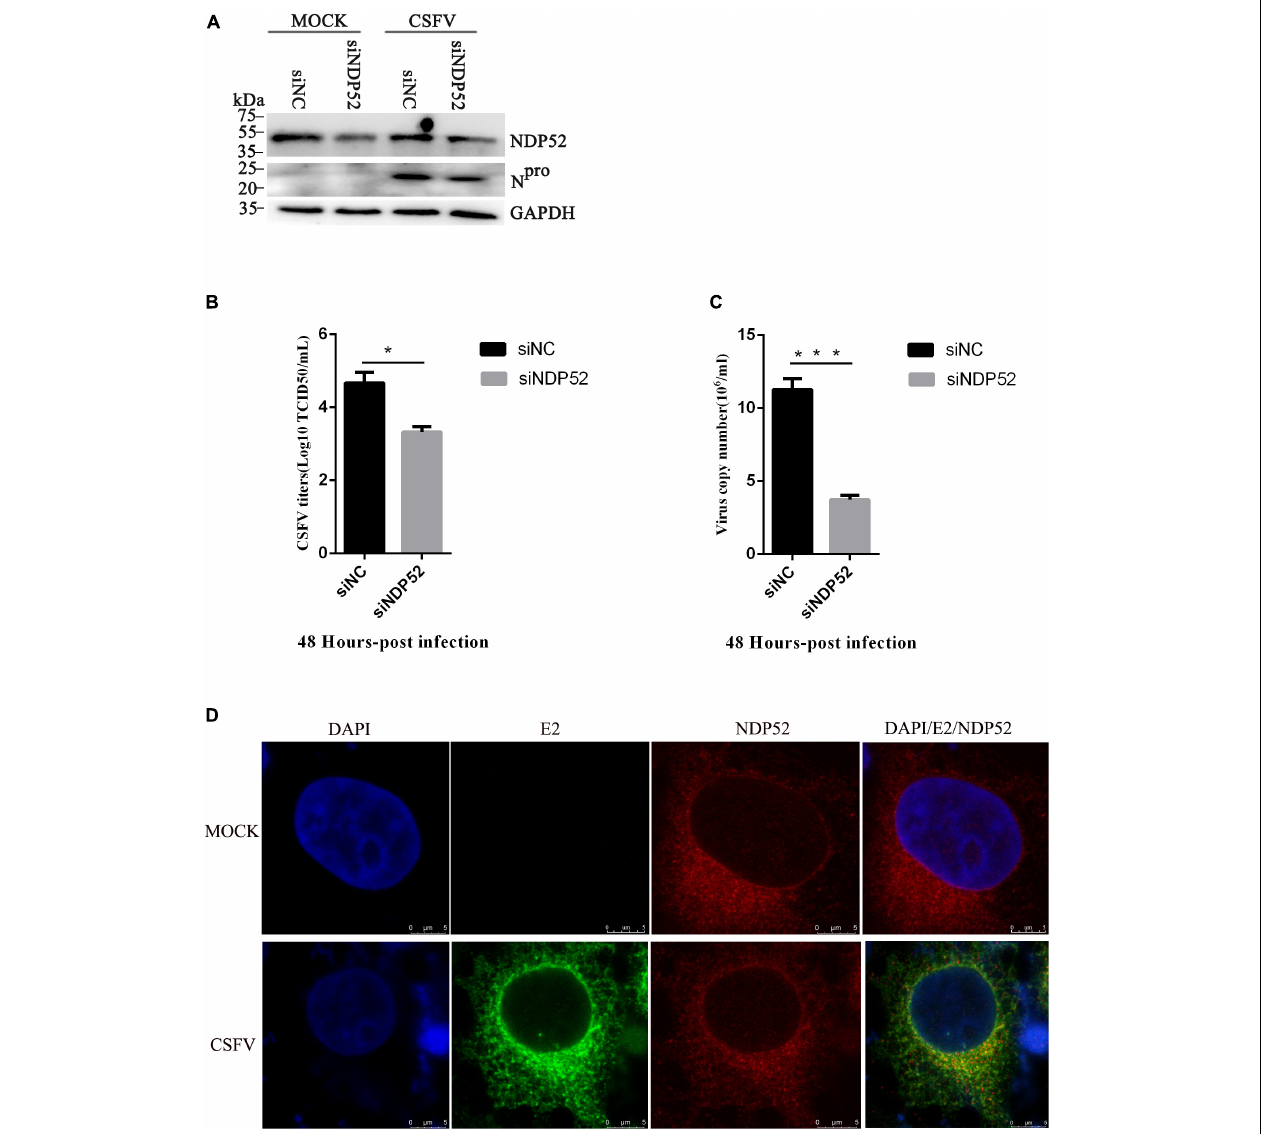
FIGURE 3 | NDP52 inhibition reduces CSFV replication. (A) PK-15 cells were mock-infected or infected with CSFV (MOI = 0.1) after transfection with siNDP52 for 24 h. NDP52 expression was analyzed by Western blotting at 24 hpi. CSFV infection was verified by immunoblotting with anti-CSFV N pro antibody. GAPDH was used as an internal loading control. (B) Statistical analysis of the effect of NDP52 siRNA transfection on the viral copy numbers in CSFV-infected cells. PK-15 cells were transfected with scrambled or NDP52 siRNA for 24 h, followed by mock infection and CSFV infection (MOI = 0.1). At 48 hpi, CSFV RNA levels were analyzed by real-time qRT-PCR (mean ± SD; n = 3; ∗ P < 0.05; ∗∗ P < 0.01; ∗∗∗ P < 0.001; # P > 0.05). P -values were calculated using an unpaired Student’s t -test. (C) Statistical analysis of the effect of NDP52 siRNA transfection on virus titers in CSFV-infected cells. PK-15 cells were transfected with scrambled or NDP52 siRNA for 24 h, followed by mock infection and CSFV infection (MOI = 0.1). At 48 hpi, CSFV titers were analyzed (mean ± SD; n = 3; ∗ P < 0.05; ∗∗ P < 0.01; ∗∗∗ P < 0.001; # P > 0.05). P -values were calculated using an unpaired Student’s t -test. (D) PK-15 cells were mock-infected or infected with CSFV (MOI = 0.1), after 24 h